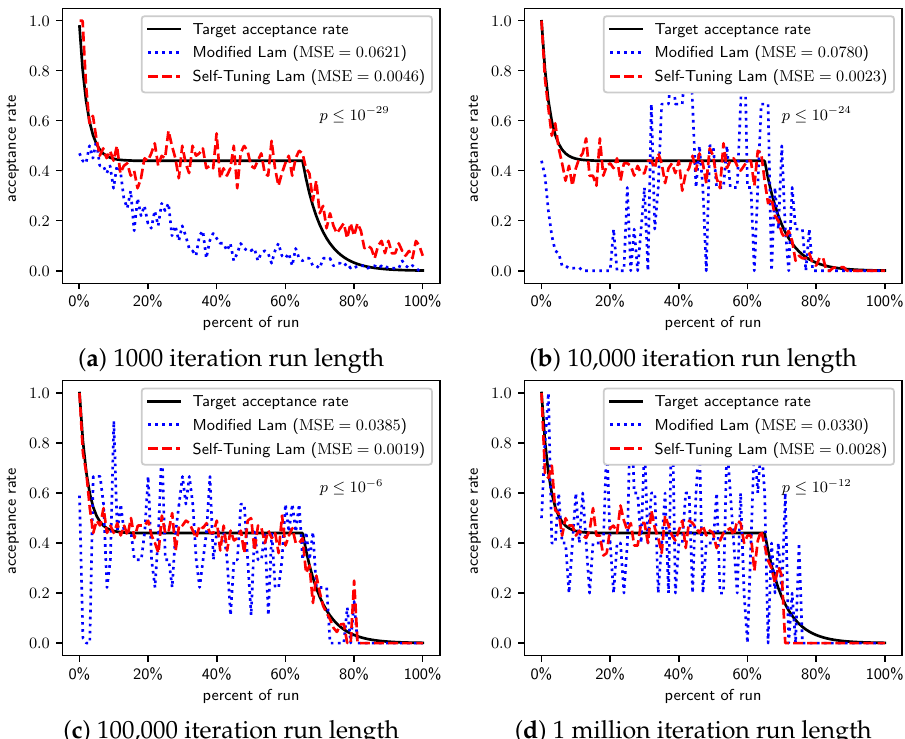
Figure 5. TwoMax problem: Self-Tuning Lam, Modified Lam, and target acceptance rates for ( a ) 1000 iterations, ( b ) 10,000 iterations, ( c ) 100,000 iterations, and ( d ) 1 million iterations.